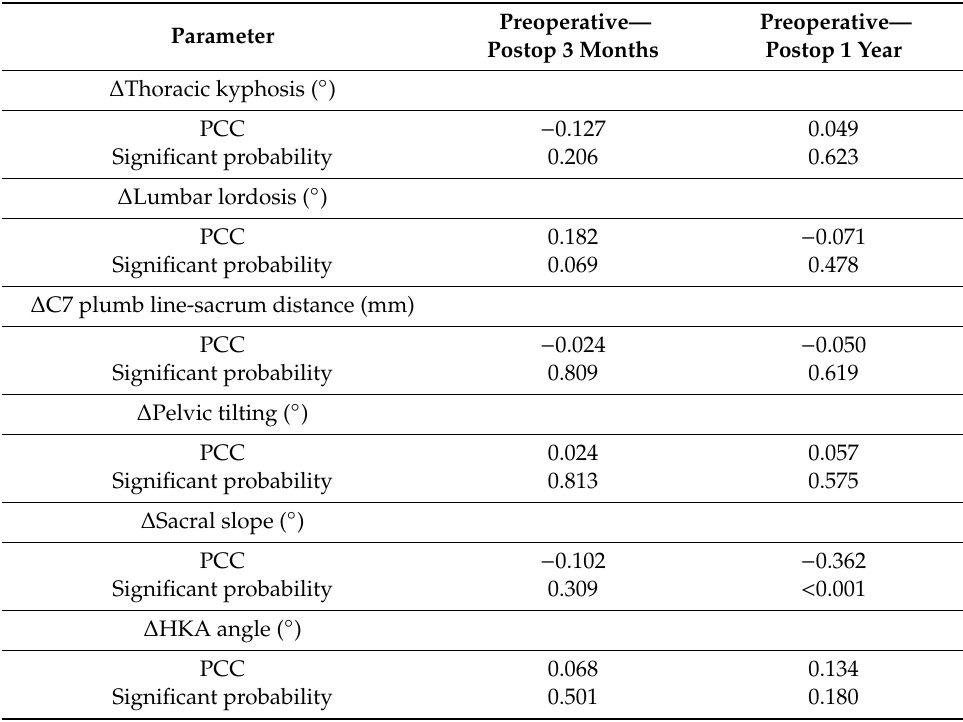
Table 4. Correlation analysis between pelvic flexibility and sagittal parameters.